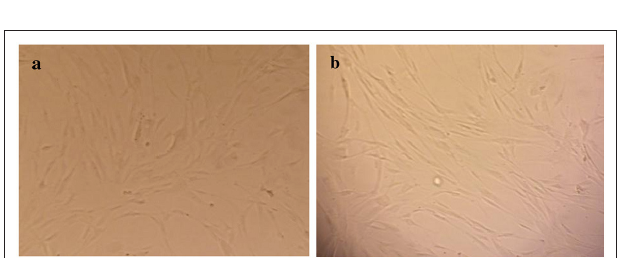
FIGURE 2 | Inverted micrograph of HuGu cells (original magnification, 40 × ; scale bar, 10 µ m); (a) Showing a spindle-shaped cell, (b) HuGu cells treated with